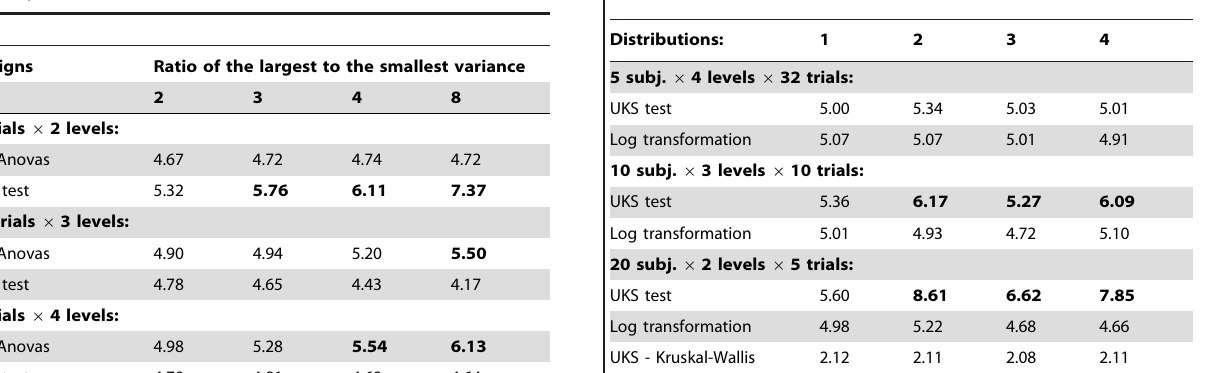
Table 2. Robustness with violations of heteroscedasticity assumption.